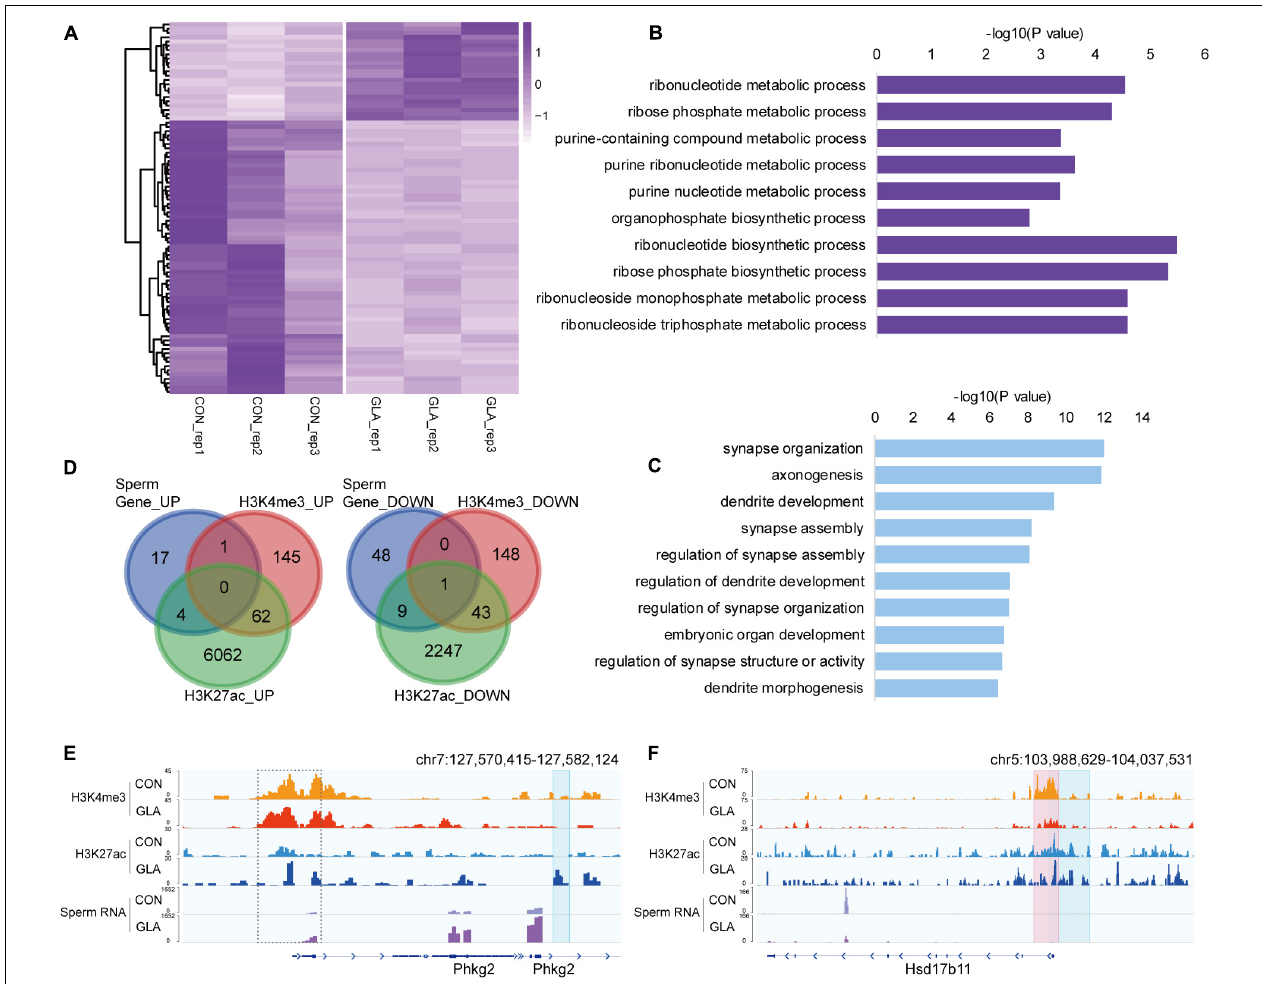
FIGURE 4 | Differential sperm mRNA transcripts in connection with H3K4me3 and H3K27ac alterations in GLA sperm. (A) Heatmap of normalized mRNA transcripts in CON and GLA sperm ( n = 10, data from Ma et al., 2021). (B,C) Selected significant pathways from Gene Ontology analysis on up-regulated (B) or down-regulated (C) genes in GLA sperm. (D) Venn diagram showing the number of regions with different mRNA transcripts levels in GLA sperm that overlap regions with altered H3K4me3 and H3K27ac levels. Left, up-regulated regions overlapping regions with increased H3K4me3 and H3K27ac. Right, down-regulated regions overlapping regions with decreased H3K4me3 and H3K27ac. (E) Integrative Genomics Viewer tracks showing up-regulated Phkg2 integrating with H3K4me3 and H3K27ac signals in GLA sperm. (F) Integrative Genomics Viewer tracks showing down-regulated Hsd17b11 integrating with H3K4me3 and H3K27ac signals in GLA sperm. Pink box indicates regions with differential H3K4me3 signals ( P -value < 0.05). Blue box indicates regions with differential H3K27ac signals ( P -value < 0.05). Dashed box indicates regions with slightly differential histone methylation signals.